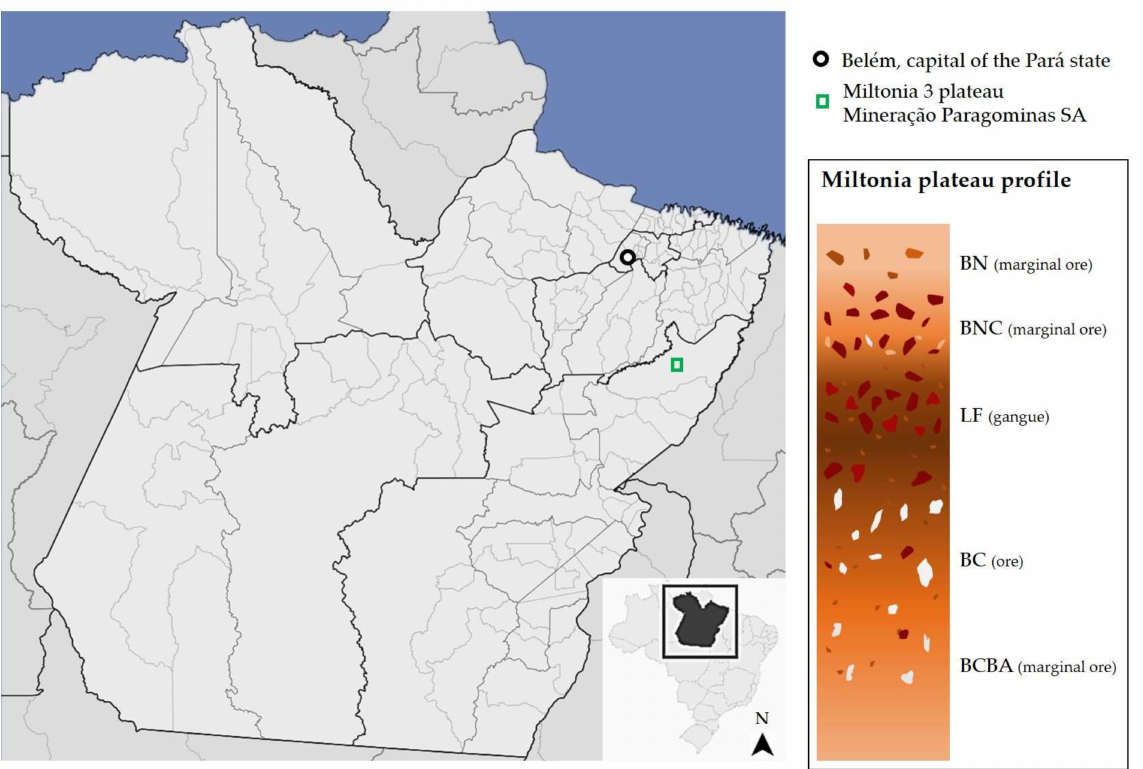
Figure 1. Location and typical geological profile of Miltonia plateau (Par á state, northern Brazil). Legend: BN: Nodular Bauxite, BNC: Nodular-Crystalized Bauxite, LF: Ferruginous Laterite, BC: Crystalized Bauxite, and BCBA: Crystalized- Amorphous Bauxite